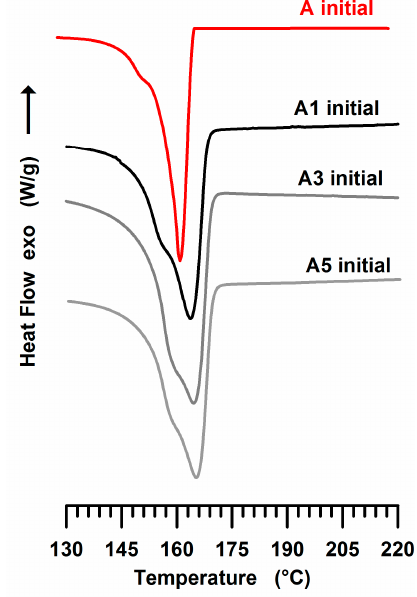
Figure 7. DSC traces of iPP (A) sample and iPP-MWCNT nanocomposites (A, A1, A3, A5).